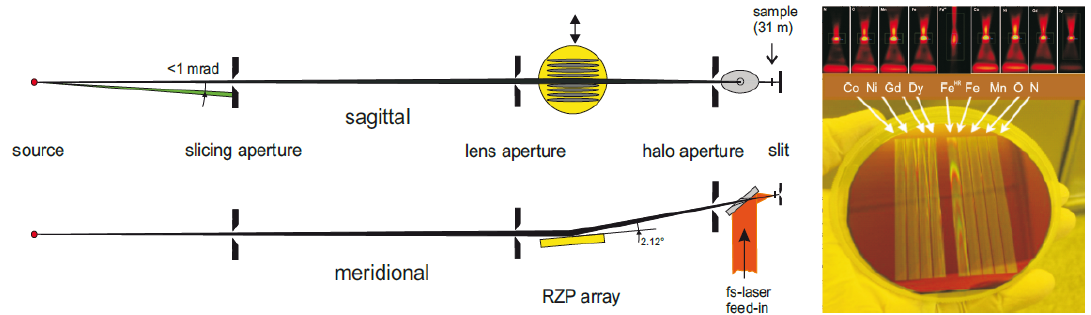
Figure 2: Optical layout (left) of the high transmission (T ∼ 0.2) ZPM (Brzhezinskaya et al., 2013; Holl- dack et al.,